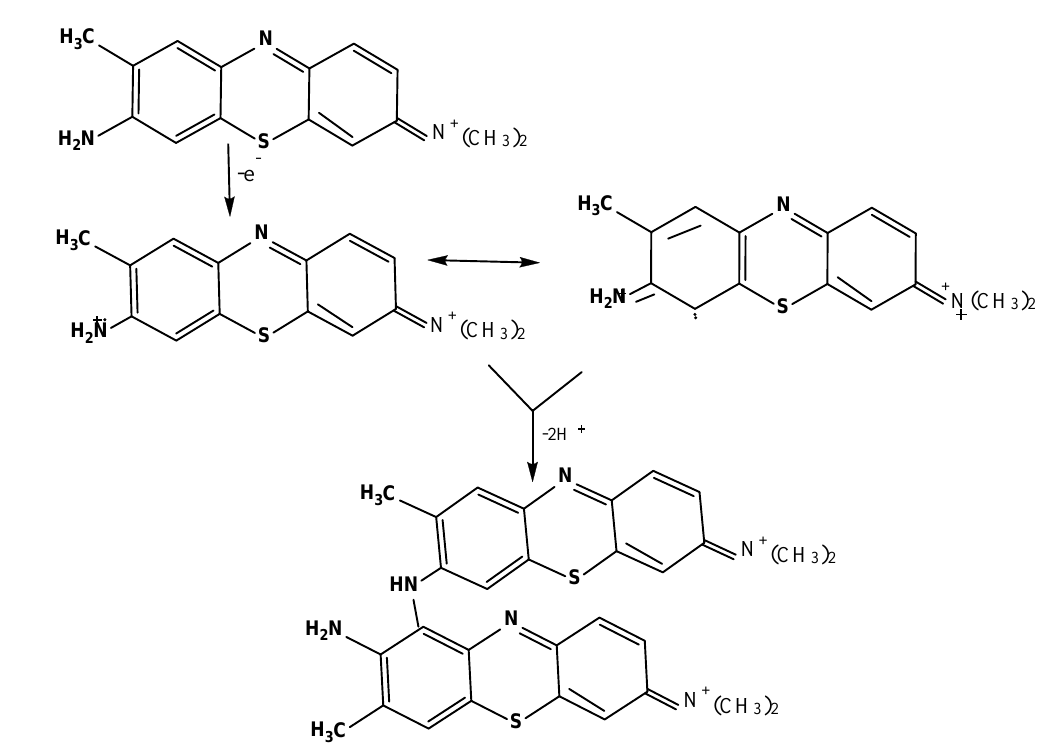
Scheme 2. TB polymerization mechanism at the Lys/HA electrode.